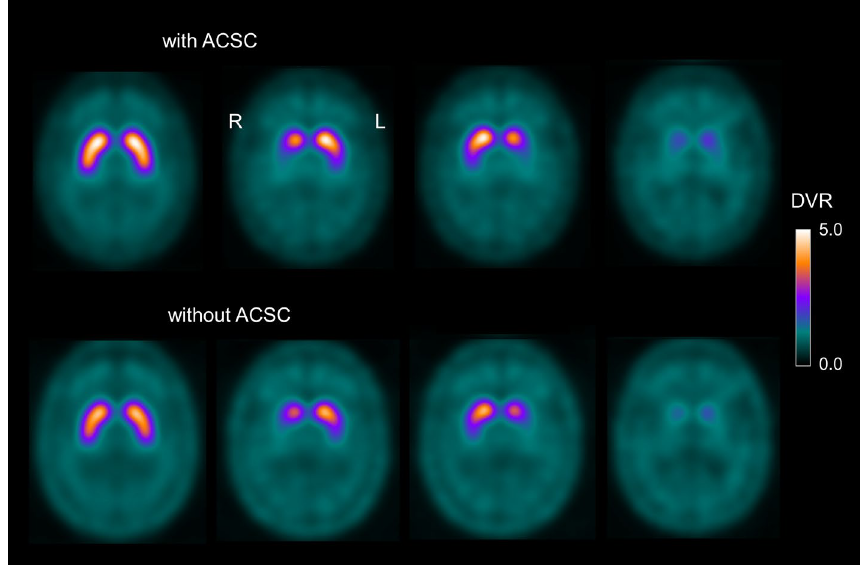
Fig. 1 Templates of the 123 I-FP-CIT distribution volume ratio (DVR) in MNI space. The templates are representative of normal striatal signal (left column), moderate (middle columns) and strong (last column) Parkinson-typical reduction of striatal uptake with and without attenuation and scatter correction (ACSC). Each template was generated from twelve randomly selected DAT-SPECT images. The 123 I-FP-CIT template representative of normal striatal signal with attenuation and scatter correction (upper left) was used for single template stereotactical